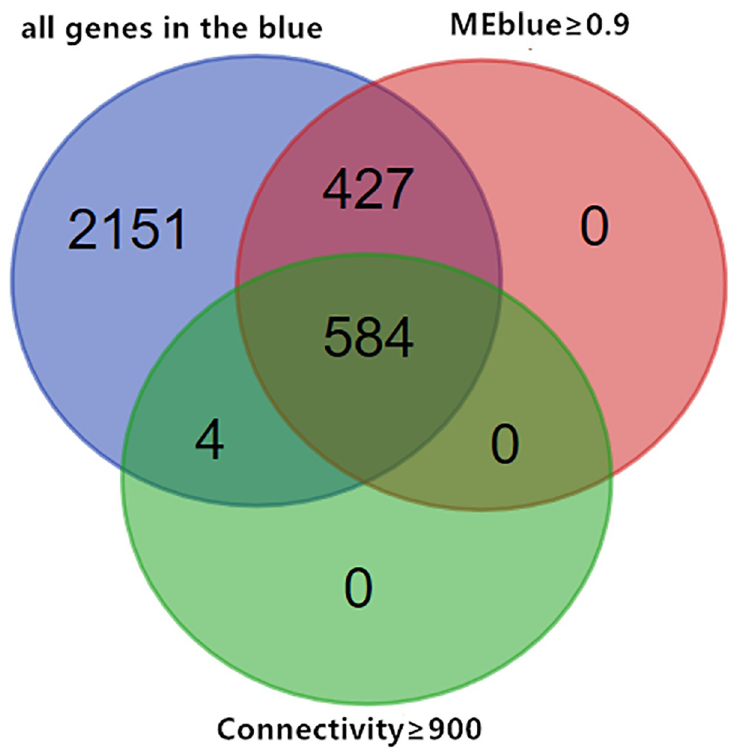
Fig 5. Venn diagram of key candidate genes for specific target modules.